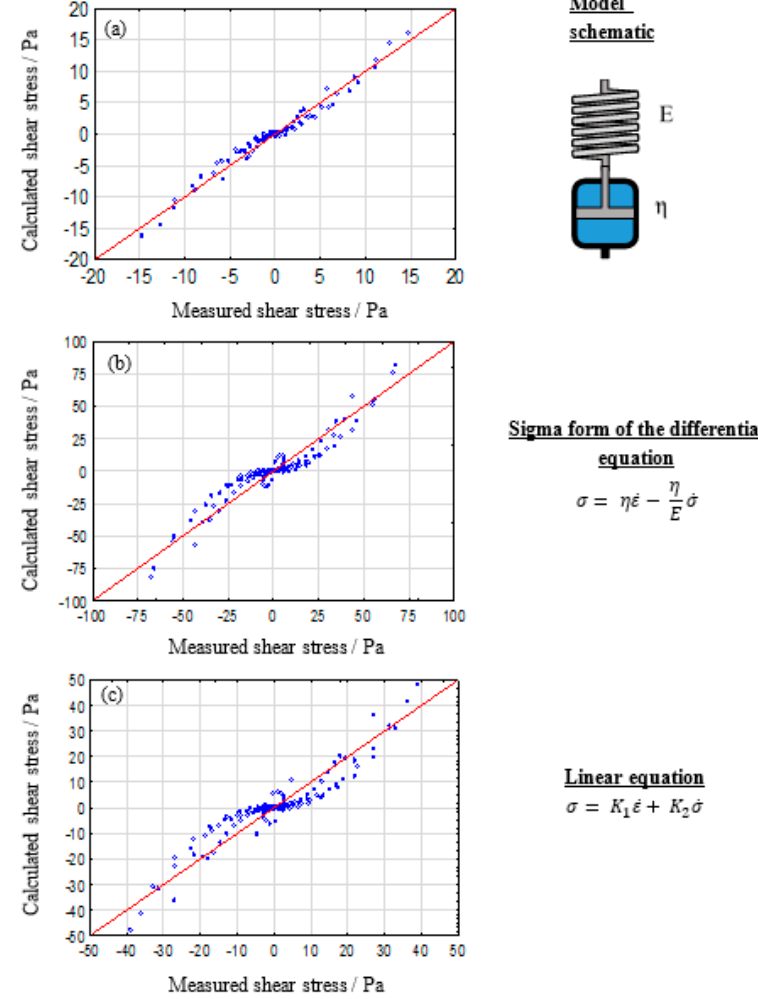
Figure 4. Calculated against measured shear stress plot for the evaluated Maxwell model for 2% ( a ), 5% ( b ), and 8% ( c ) alginate